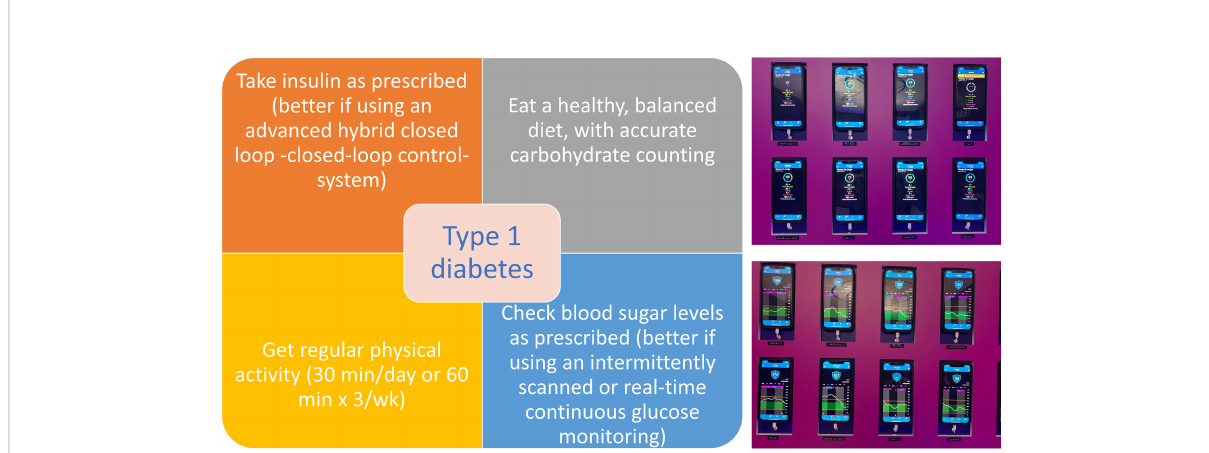
FIGURE 1 Updated type 1 diabetes management pillars (left), with an example of how technology can help. The continuous glucose monitoring pro fi les (right, bottom) and time in range percentages (right, top) of eight adolescents and young adults participating in the Transition Lab experiential training event held in Coccaglio, BS, Italy August 26-29,